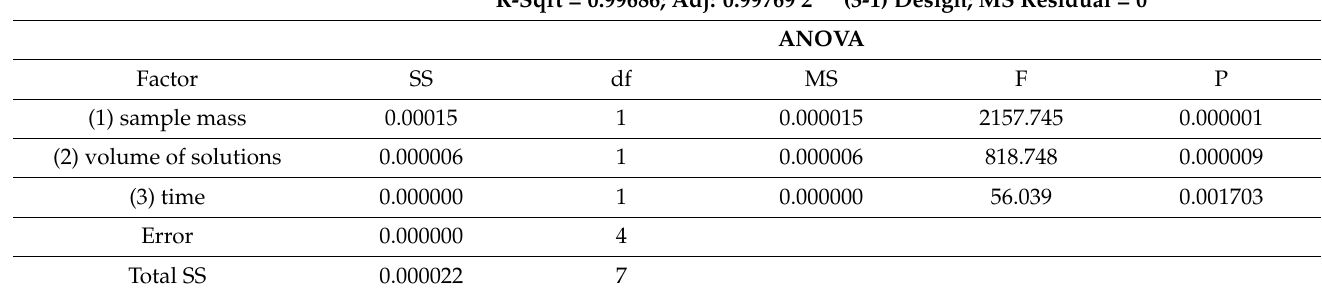
Table 1. Analysis of variance—ANOVA—for the model generated through fractional factorial design 2 3-1 with replication.